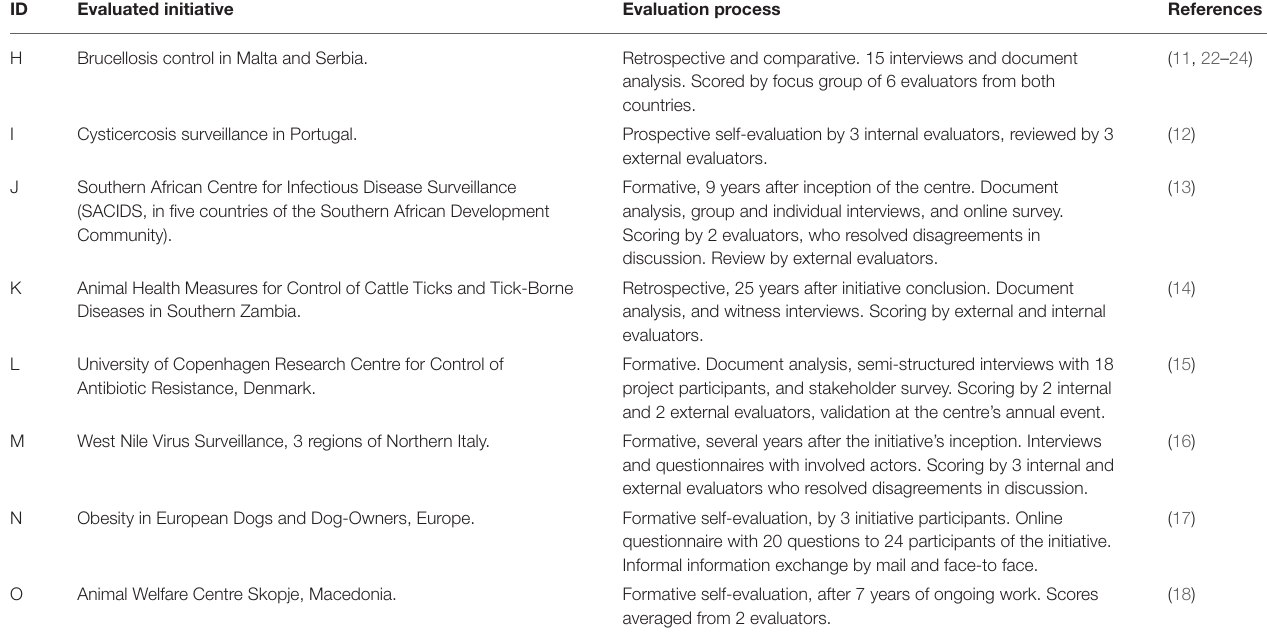
TABLE 1 | Overview of the eight case studies evaluated with the NEOH tool. ID Evaluated